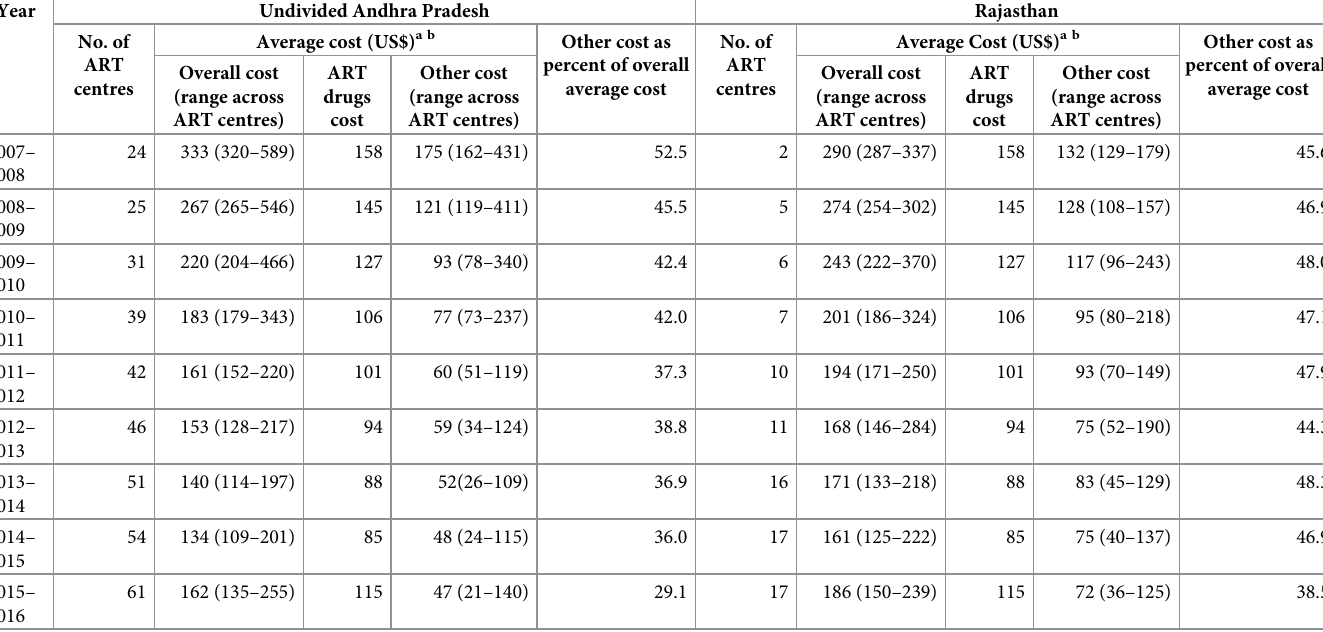
Table 3. Average cost per patient alive and on ART in public sector ART centres in undivided Andhra Pradesh and Rajasthan states in India from fiscal year 2007– 2008 to 2015–2016.